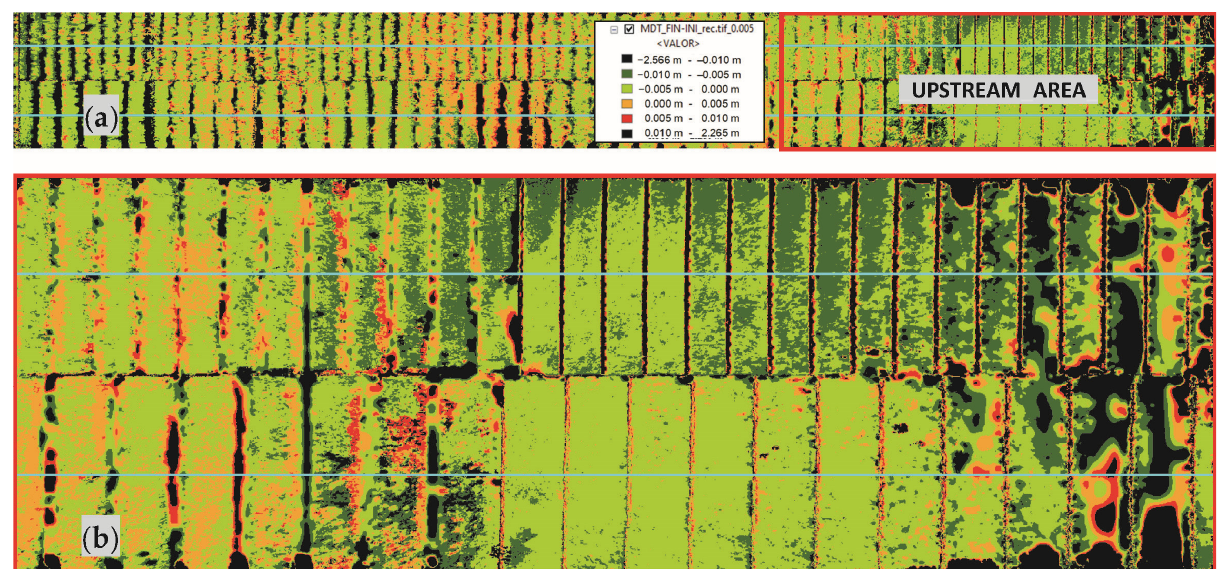
Figure 16. ( a ) Sketch of the situation of the upper rows in the test chute. ( b ) Detail of the upstream area of the channel (rows #53 to #81 of the small WSB, in the upper part of the photograph, and rows #35 to #54 of the medium WSB, at the bottom of the figure).